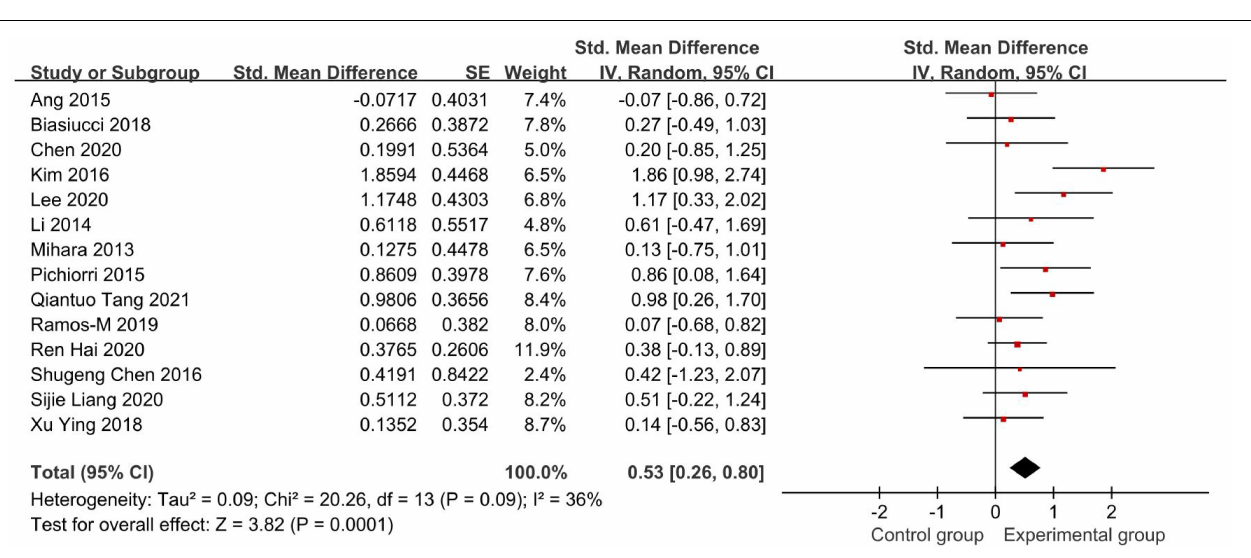
FIGURE 5 | Forest plot of the FMA score after omitting Xianwen Xiang’s study to evaluate the effect of BCI on upper limb dysfunction after